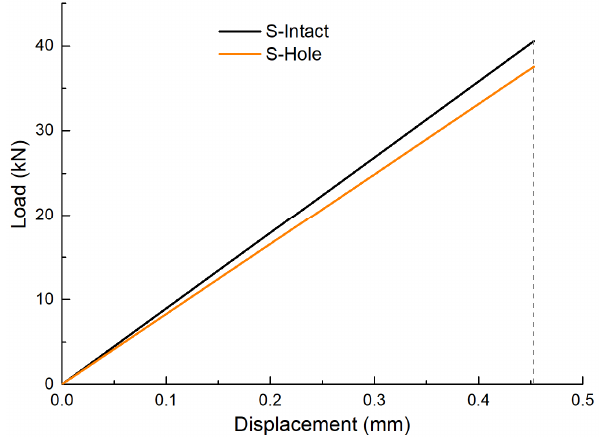
Figure 7. Load versus displacement curve of two models. Table 4. The strain energy of each part.